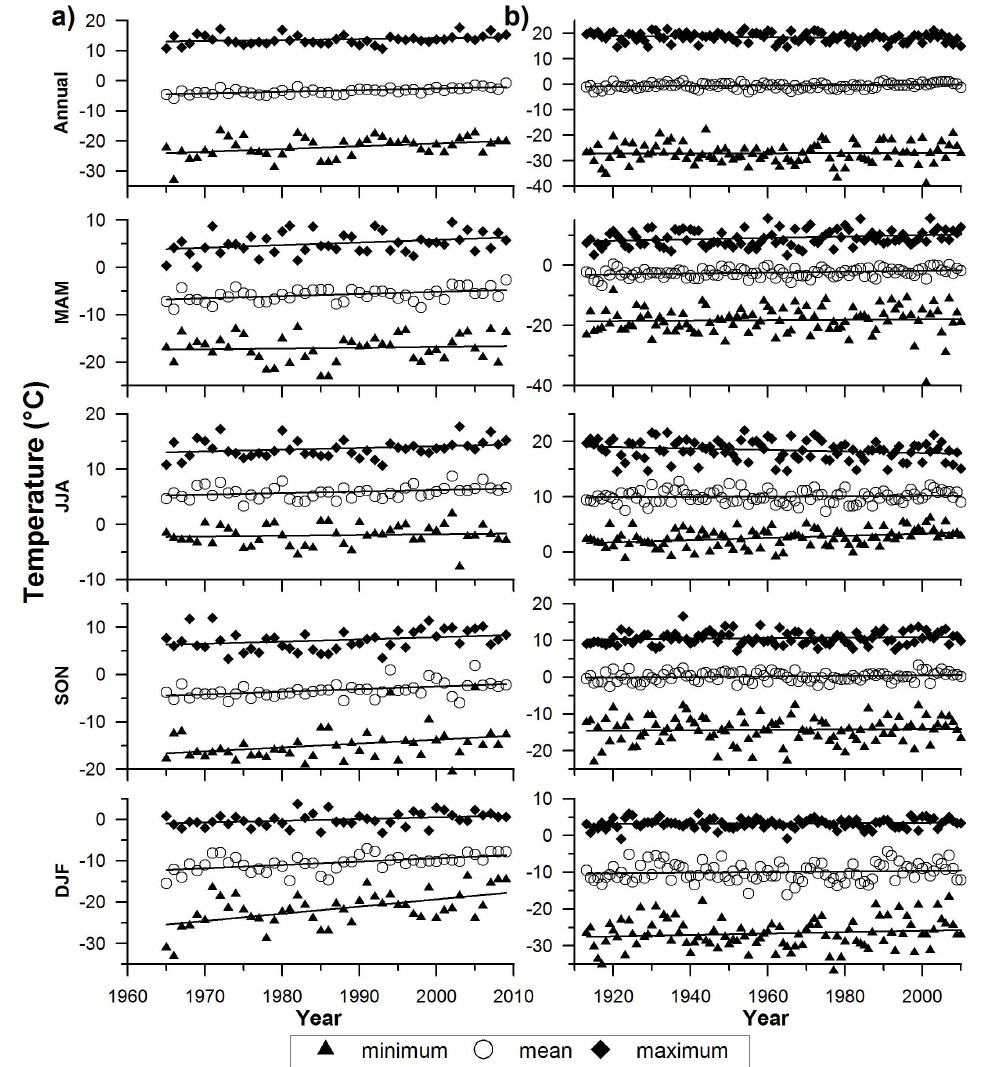
Fig. 2. Time series of annual and seasonal air temperatures ( ◦ C) for (a) Tarfala and (b) Abisko catchments. The maximum, mean and minimum annual and seasonal temperatures are indicated by a filled diamond, open circle and filled triangle respectively. Black lines indicate linear regressions versus time. Linear change rates and MK trend statistics are presented in Tables 2 and